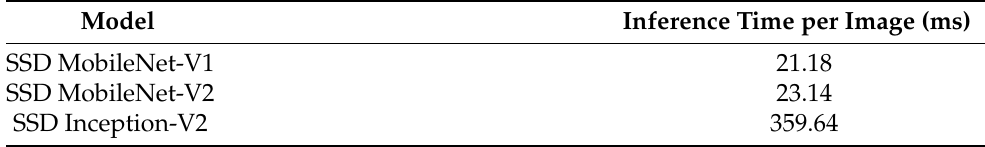
Table 5. Inference time per image (ms) of each trained model deployed on the edge TPU device.